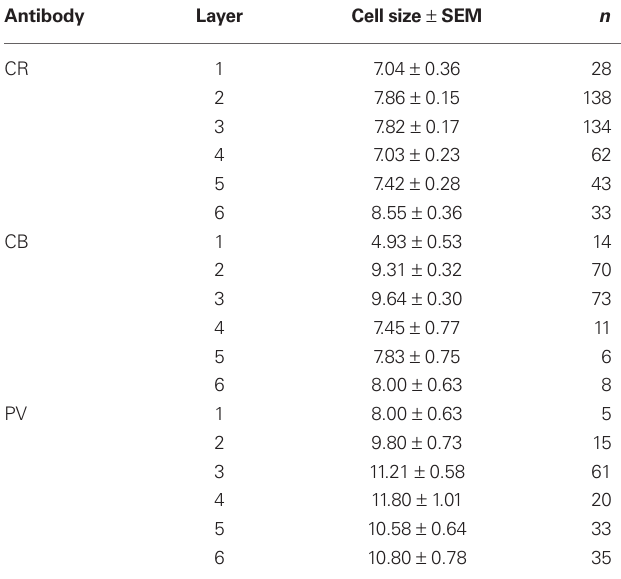
Table 2 | Cell size by